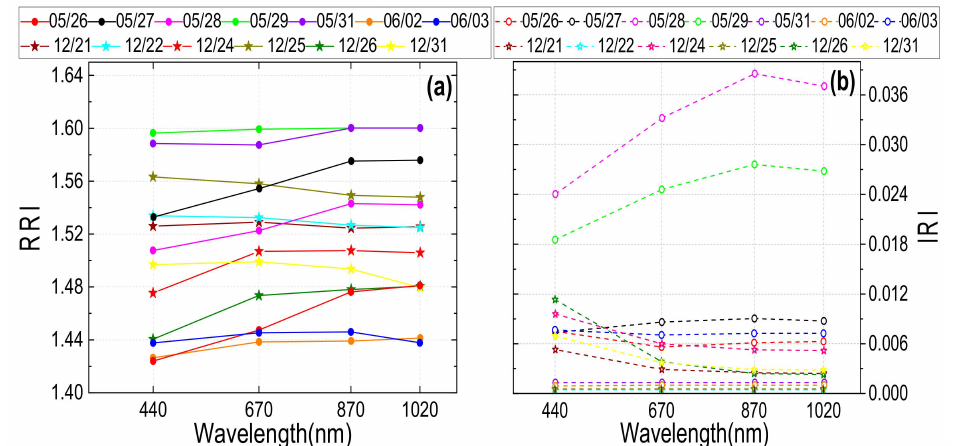
Figure 7. The Spectral profile of ( a ) RRI (real part of the refractive index) and ( b ) IRI (imaginary part of the refractive index) during the two pollution